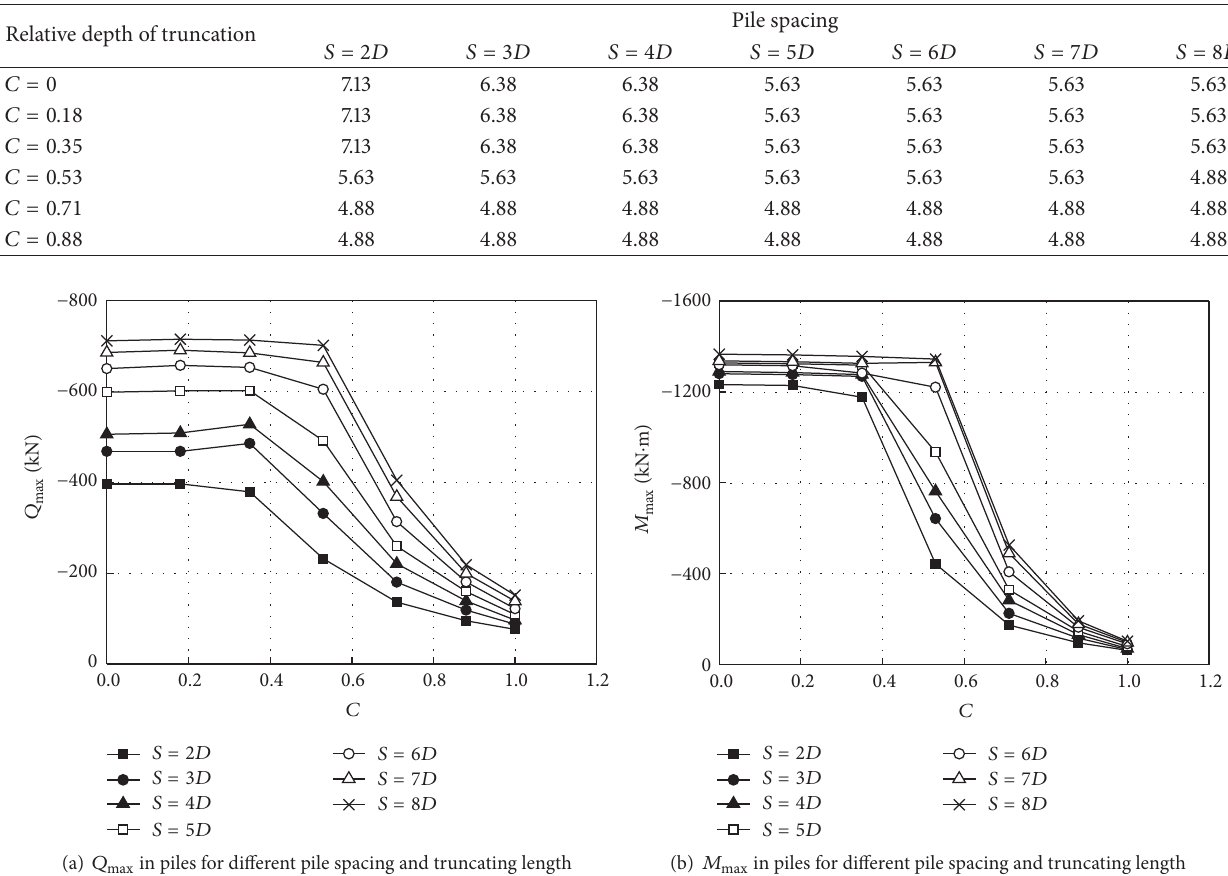
Figure 12: Variation of 𝑄 max and 𝑀 max in truncated piles with pile